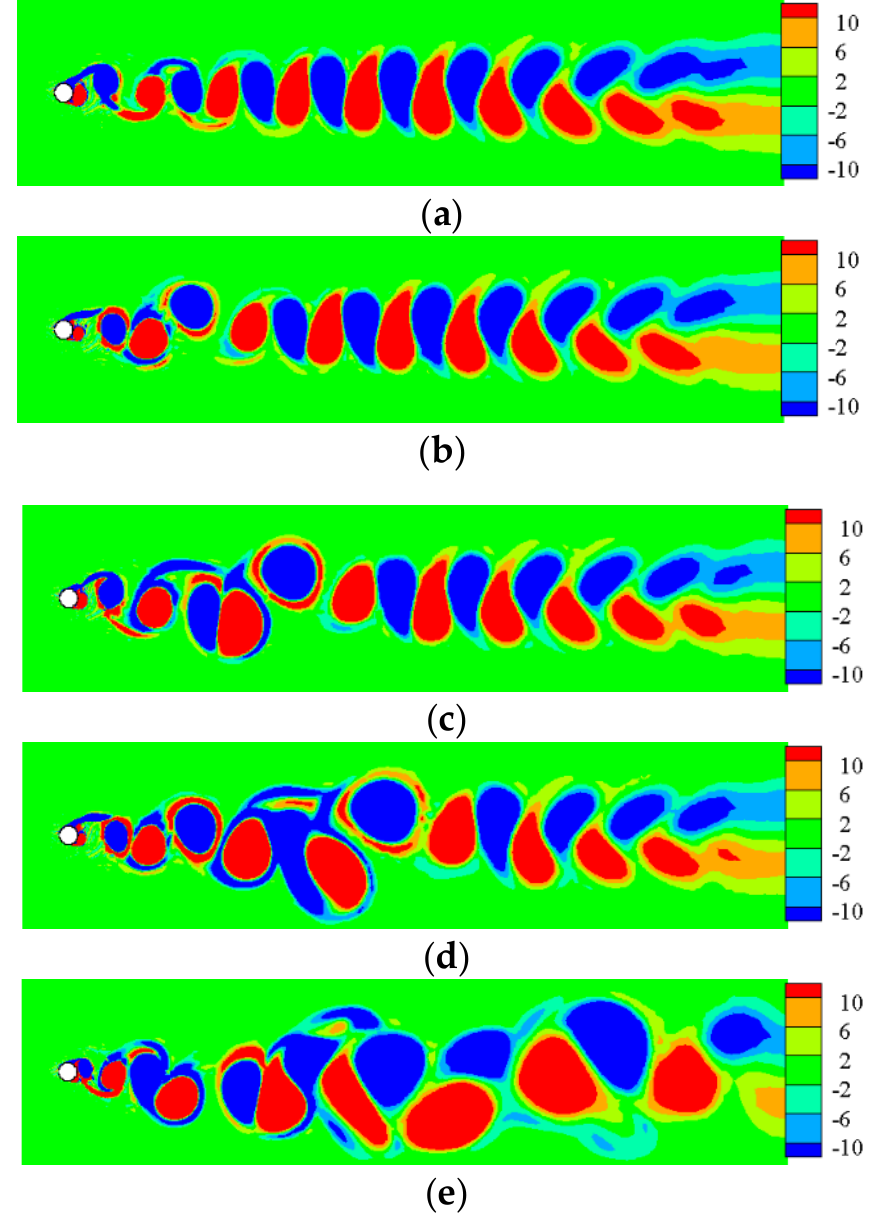
Figure 8. The vorticity contours of TWW cylinder with “Upstream” propagation. ( a ) t = 2.16 s. ( b ) t = 2.31 s. ( c ) t = 2.46 s. ( d ) t = 2.61 s. ( e ) t = 2.97 s.